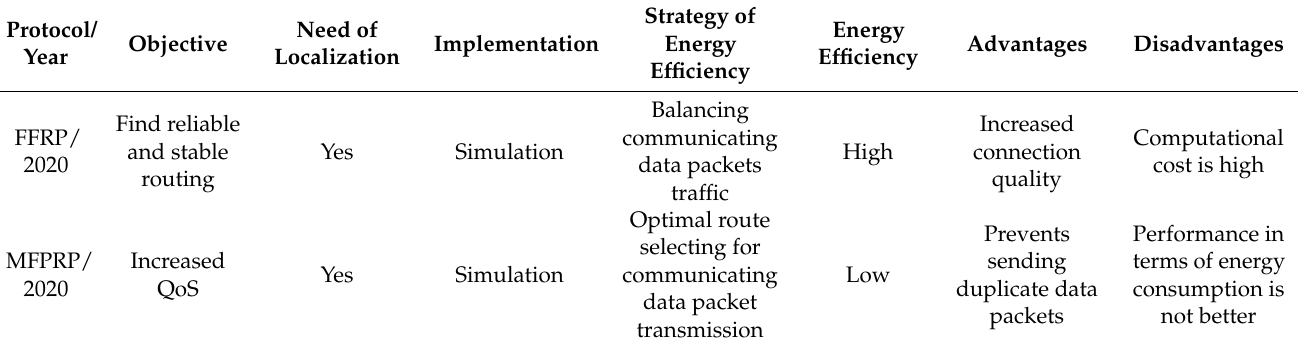
Table 8. Comparison of bio-inspired energy-efficient routing protocols (bio-inspired